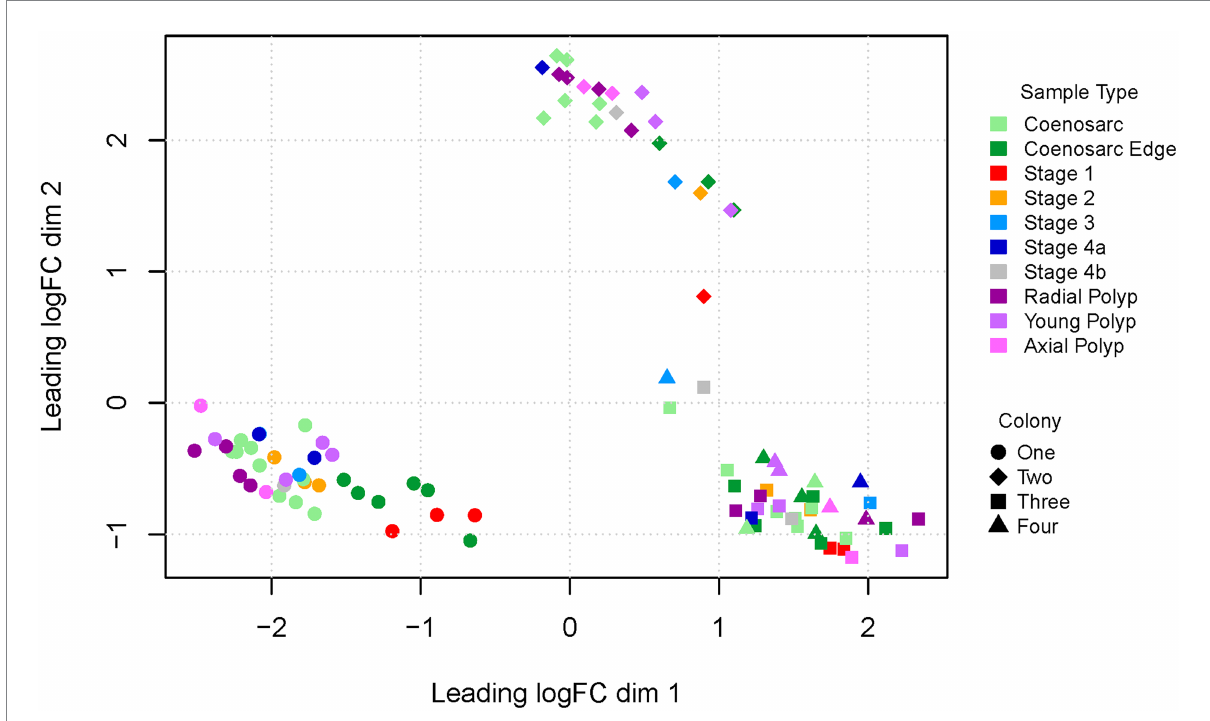
FIGURE 2 Multi-dimensional scaling plot (dimensions 1 and 2) of RNA-Seq samples representing regeneration of A. millepora . Colony one and two were housed in a closed system in Canberra, colony three and four were from open system in Orpheus